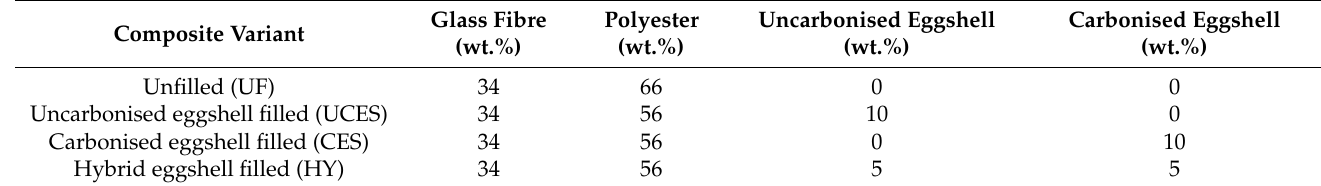
Table 3. Composite variants and their